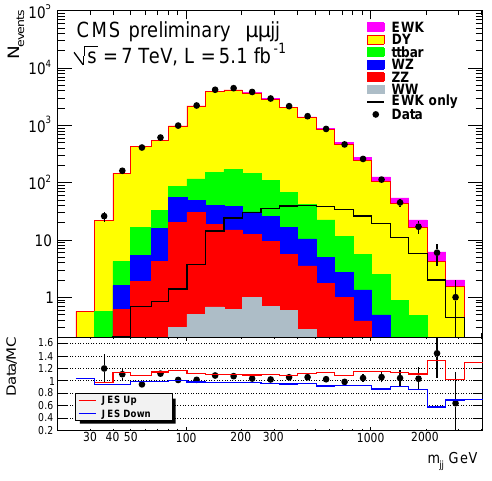
Figure 3. The m jj distribution after selection [12]. The expected contributions from the dominant Drell-Yan background and the signal processes are evaluated from the fit and the contributions from the small t ¯ t and diboson backgrounds are estimated from simulation. The signal labeled EWK is shown in pink. The bot- tom panel shows the ratio of data over the expected contribution Figure 2. Distributions of the logarithm of the transverse thrust of the signal plus backgrounds along with the statistical uncer- > 150 GeV) from data [8] for the boosted phase space ( p Z T tainties. The red and blue lines indicate the systematic uncer- and simulations from SHERPA, POWHEG, PYTHIA and MAD- tainty due to the jet energy scale GRAPH. The error bars on the data points represent the statistical uncertainty on the data after the unfolding, the shaded (yellow) bands represent the sum of statistical and systematic errors. The lower plot shows the ratio between data, SHERPA and POWHEG with respect to MADGRAPH. The ratio between PYTHIA and MADGRAPH is not shown due to large deviations. The shaded yellow band represents the total error on the data on the ratio data-MADGRAPH, the dashed cyan band around 1 represents the relative statistical error on the MADGRAPH distribution.